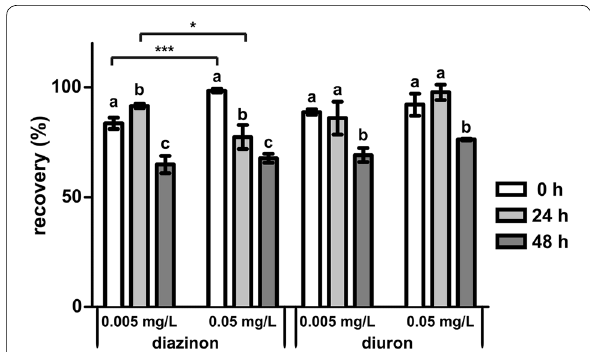
Fig. 8 Recovery of diazinon and diuron from the exposure solutions at 0 h, 24 h and 48 h. Recovery values were calculated comparing the concentration at different time points with the concentration measured in the same media without embryos. Bars represent means with standard deviation of three replicates. Significant differences between different exposure periods are labeled with different letters and significant differences between different exposure concentrations are labeled with * p < 0.05 and *** p < 0.001